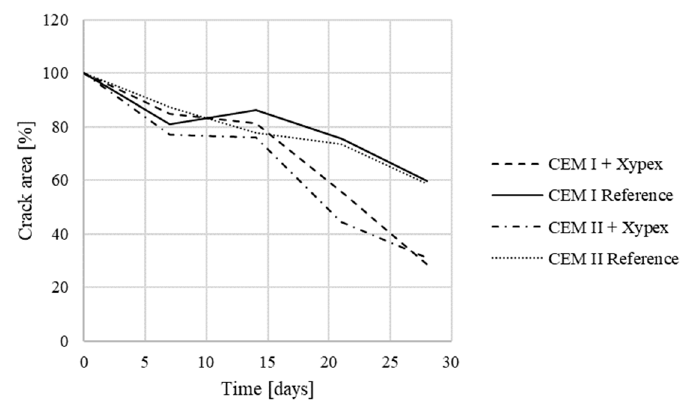
Figure 15. Crack development in specimens—the third phase.